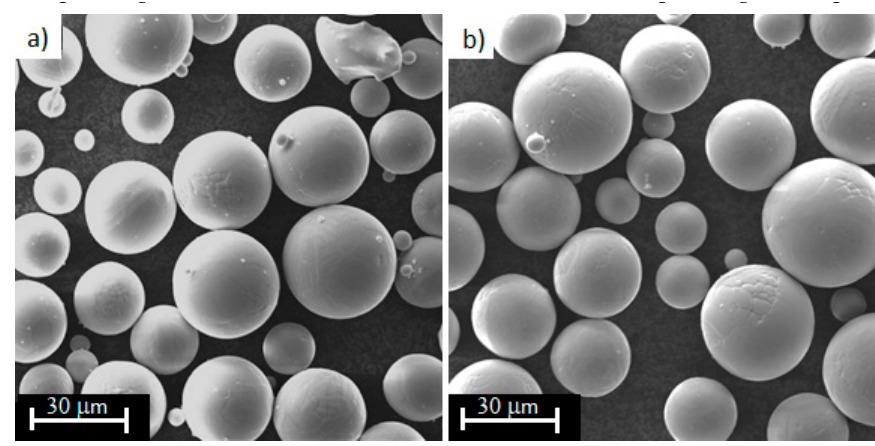
Figure 2. Morphology of the Ti6Al4V titanium alloy powder used during the printing process: ( a ) new powder, ( b ) reused powder (20 times).